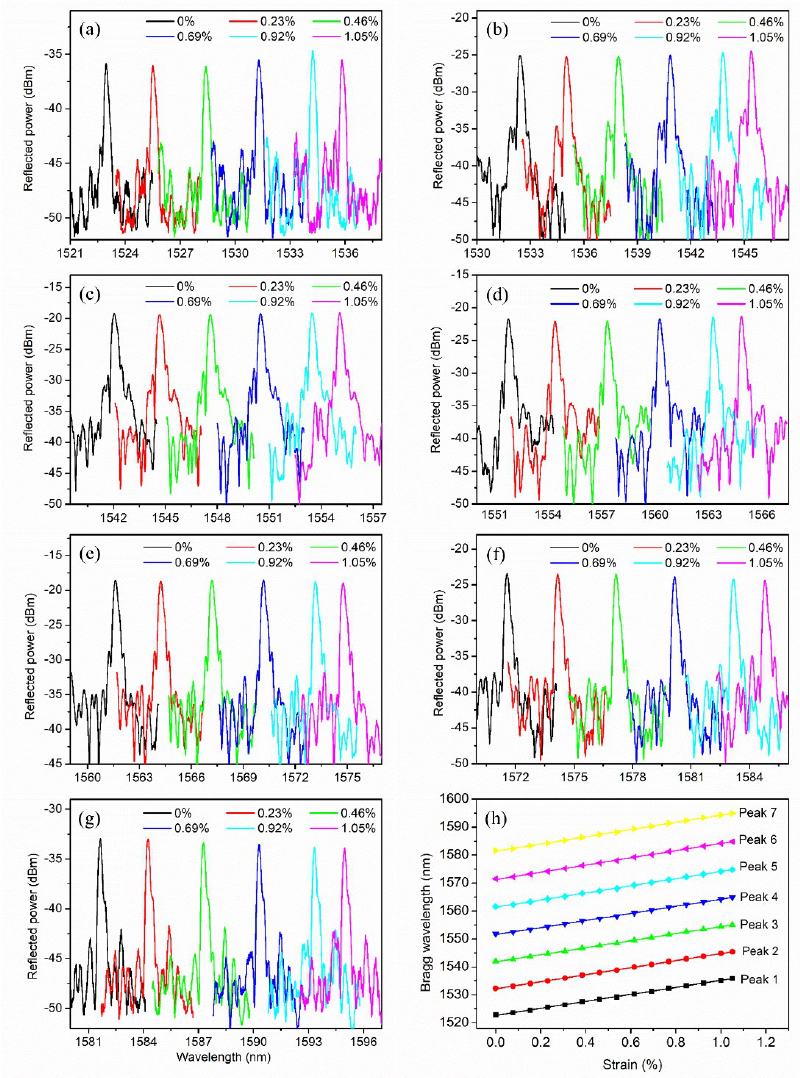
Figure 6. The spectrum ( a ) and Bragg wavelength shift ( b ) in terms of the strain from 0% to 1.08% for FBG 1 in the first regime.